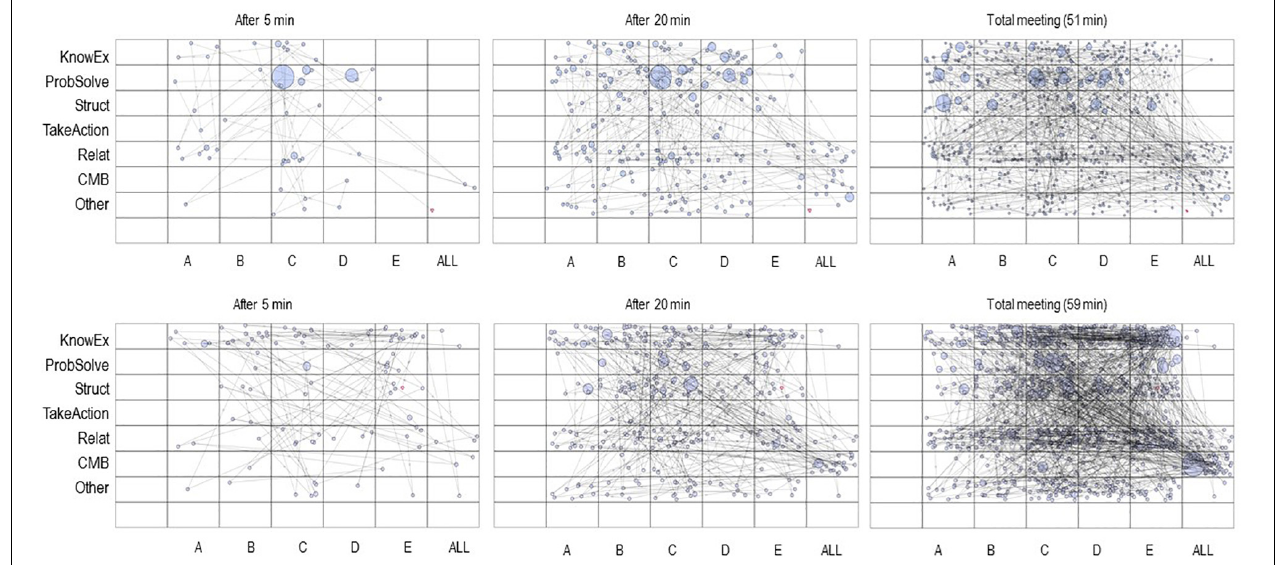
FIGURE 3 | State space grids (SSGs) representing verbal team interactions for a productive and an unproductive team at three time points for the last meeting. These are the same teams as in Figure 2 . The (top) three panels show the SSGs of the productive team. The bottom three panels show the SSGs of the unproductive team. A, B, C, D, and E label each of the five team members per team. The size of the circles denotes the duration of each event. KnowEx, knowledge exchange; ProbSolve, problem solving; Struct, structuring; TakeAction, taking initiative; Relat, relational; CMB, counterproductive meeting behavior; Other, verbal behaviors that do not fit any of the six functional categories.